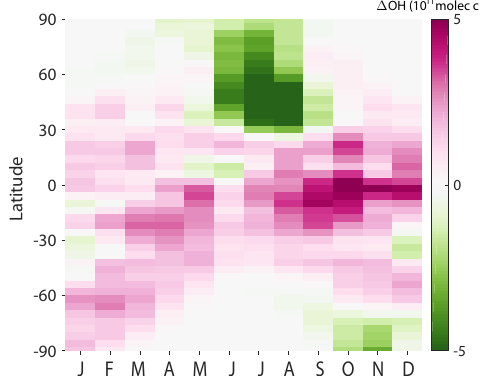
Figure B2. Zonal averages of the difference in total column OH (moleculescm − 2 ) between the base and updated monthly OH